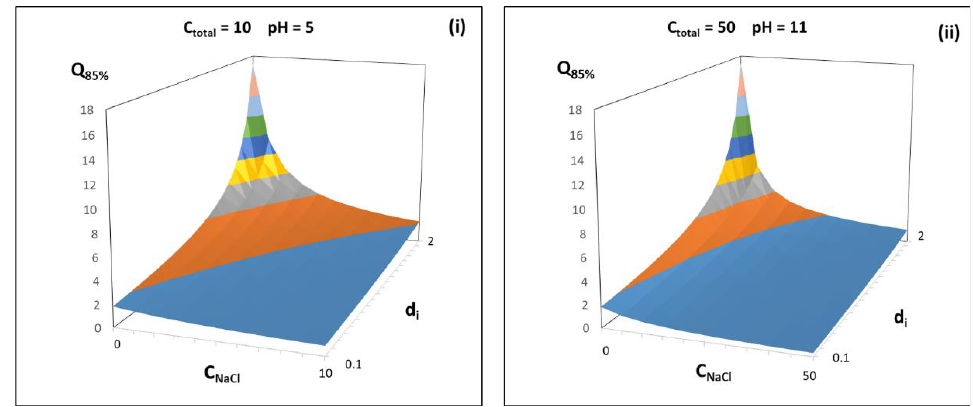
Figure 7. Modelled values of current required to achieve 85% decolouration. ( i ) C total =50 and pH = 5; ( ii ) C total =50 and pH = 11.